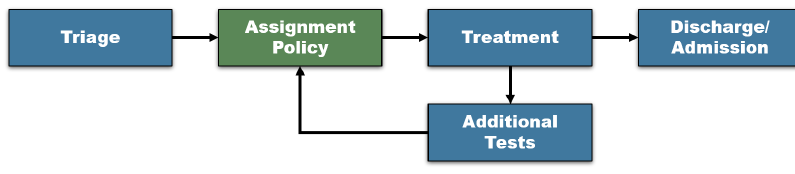
Figure 1. The common ED